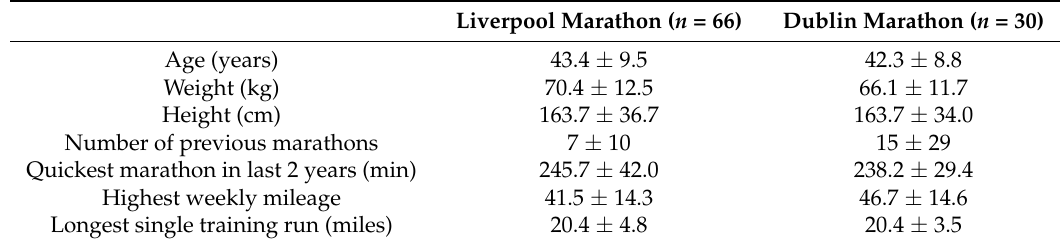
Table 1. Subject characteristics of recreational marathon runners (values are mean ± standard deviation